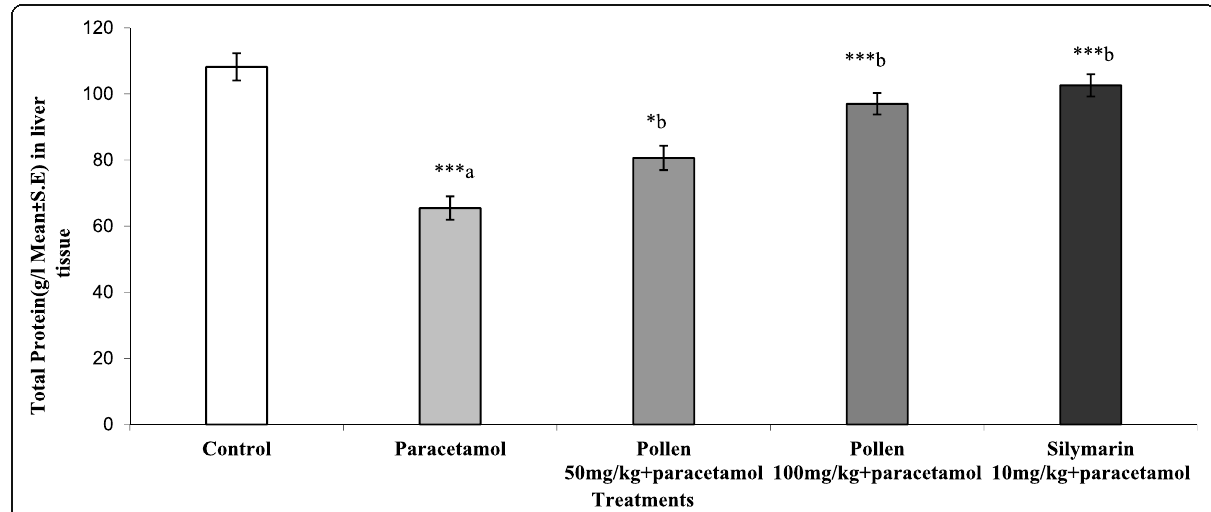
Fig. 3 Liver tissue Total Protein levels. Total Protein levels in rats intoxicated with APAP alone and treatment with DPP and Silymarin. All values represent mean ± SEM. * p < 0.05; *** p < 0.001; ANOVA, followed by Dunnett ’ s multiple comparison test. a As compared with control group. b As compared with APAP